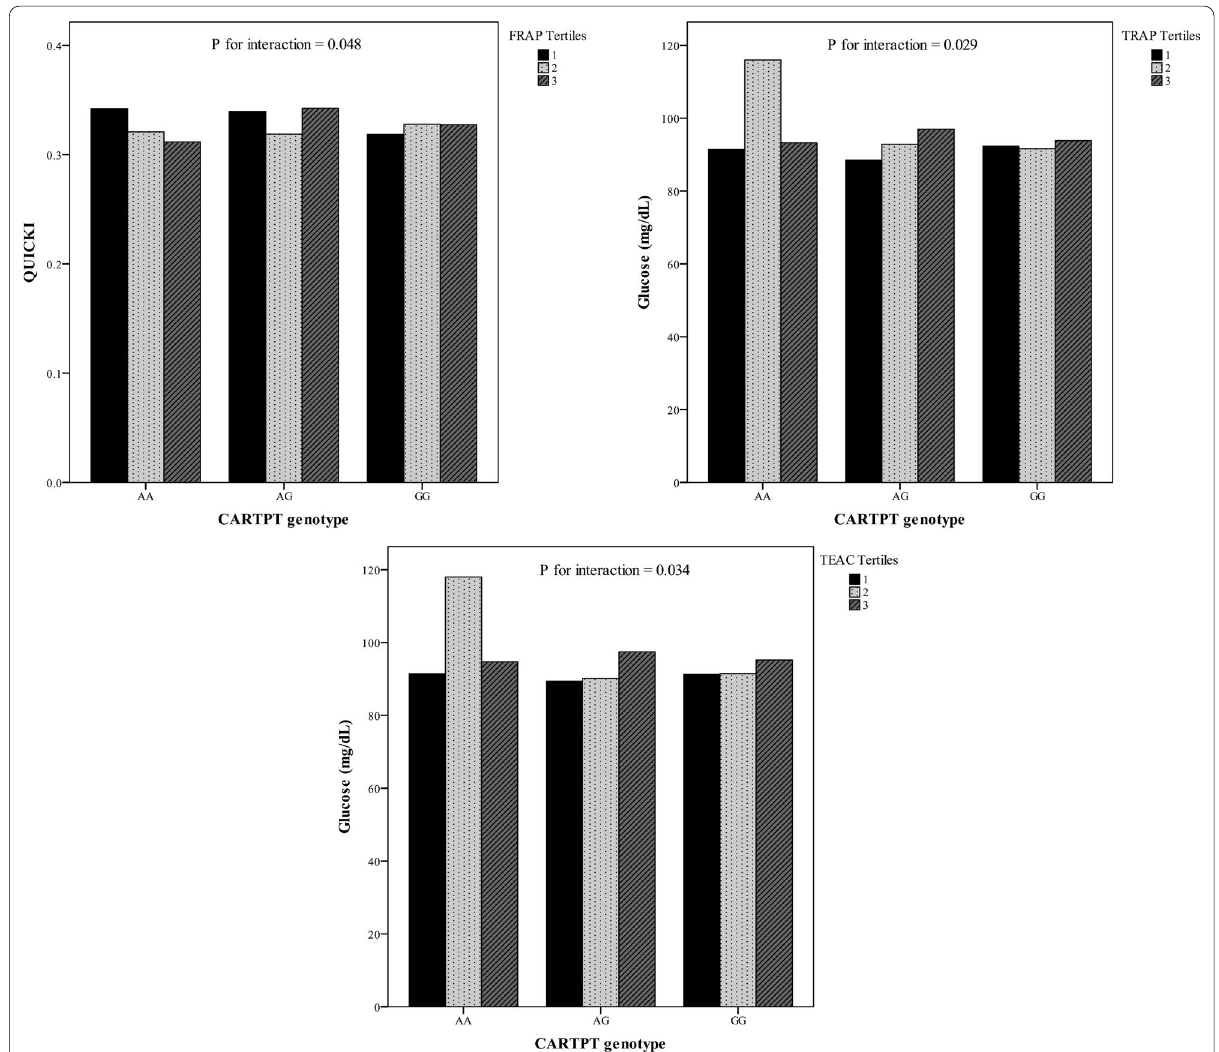
Fig. 3 Significant interactions between dietary NEAC (FRAP, TRAP and TEAC) and rs2239670 genotypes in relation to the quantitative insulin sensitivity check index (QUICKI) and serum glucose